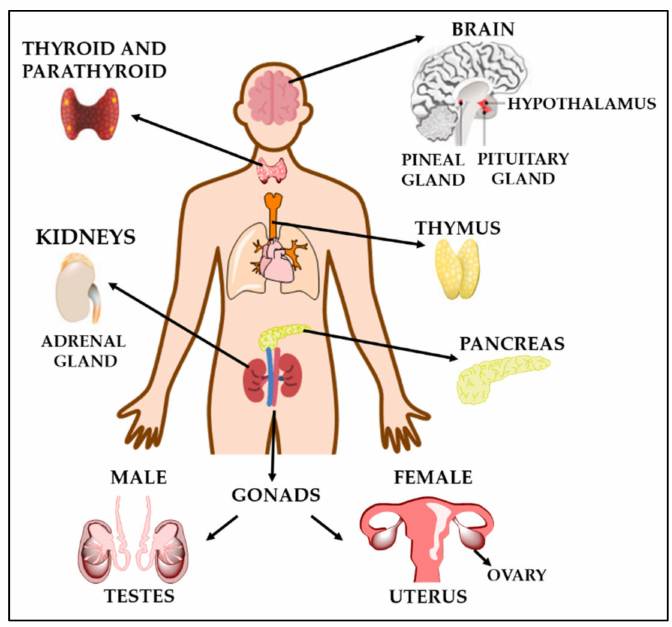
Figure 5. Representation of main endocrine glands targeted by